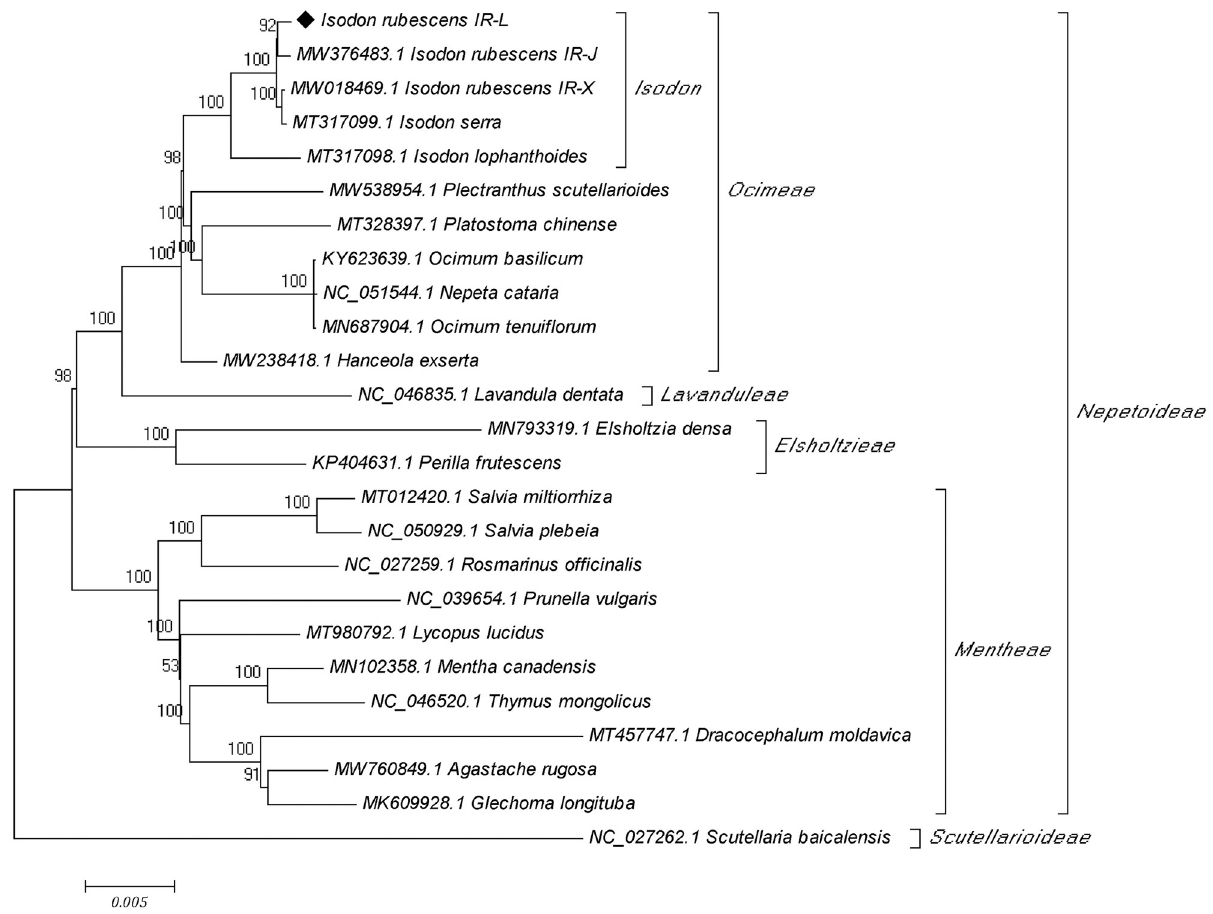
Fig 5. Phylogenetic tree based on the complete chloroplast genomes from 25 species constructed using the maximum likelihood method. The Scutellaria baicalensis cpDNA sequence was used as the outgroup. Bootstrap values are shown at the nodes.